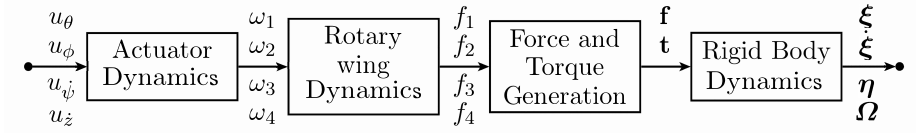
Figure 2. Block diagram of the UAV complete